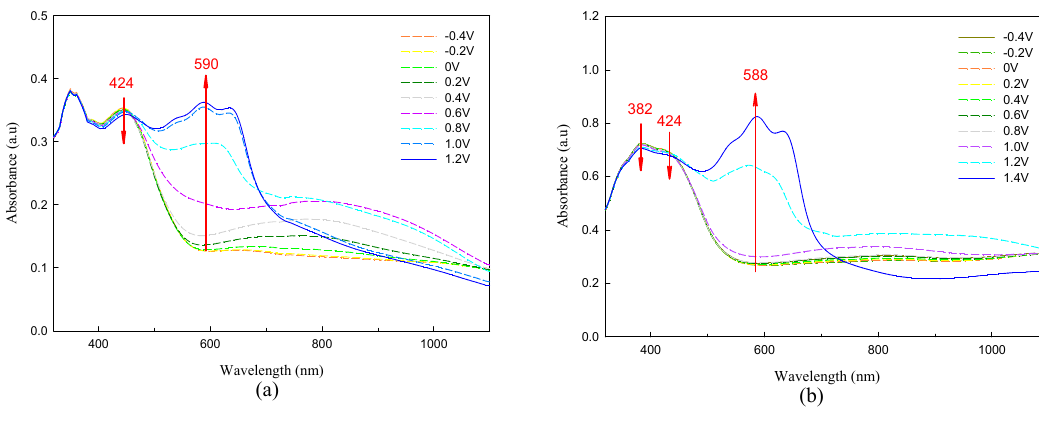
Figure 8. Spectroelectrochemical spectra of: ( a ) P(TTPA- co -DIT)/PProDOT-Et 2 ; and ( b ) P(TTPA-co-BDTA)/PProDOT-Et 2 ECDs as applied potentials between − 0.4 V and 1.2 V. P(TTPA- co -DIT) and P(TTPA- co -BDTA) films were prepared potentiostatically at 1.0 V.